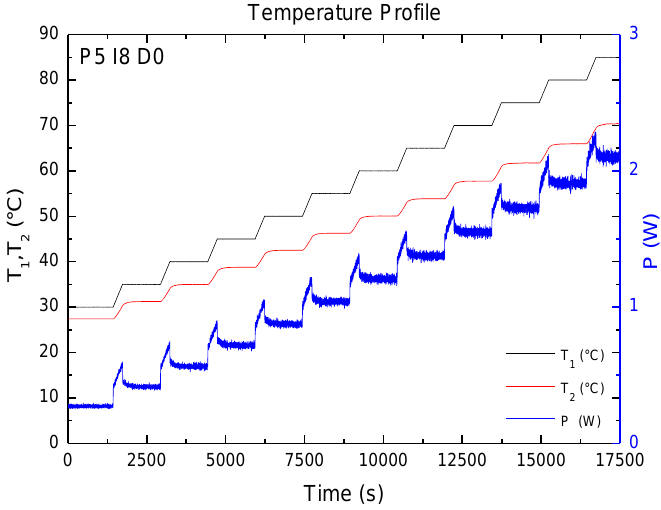
Figure 2. The temperature profile, used to study the noise level, consists of the copper temperature, T (black), the fluid temperature, T (red) and the power applied to the heating 1 2 element (blue). The profile comprises plateau phases and ramping phases and is presented with a PID configuration of